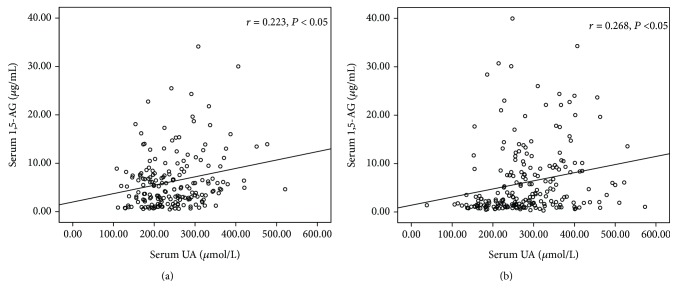
The relationship, as shown by Pearson's correlation coefficient, between levels of serum 1,5-AG and serum UA (a) in men (r = 0.213, P < 0.05) and (b) in women (r = 0.223, P < 0.05).